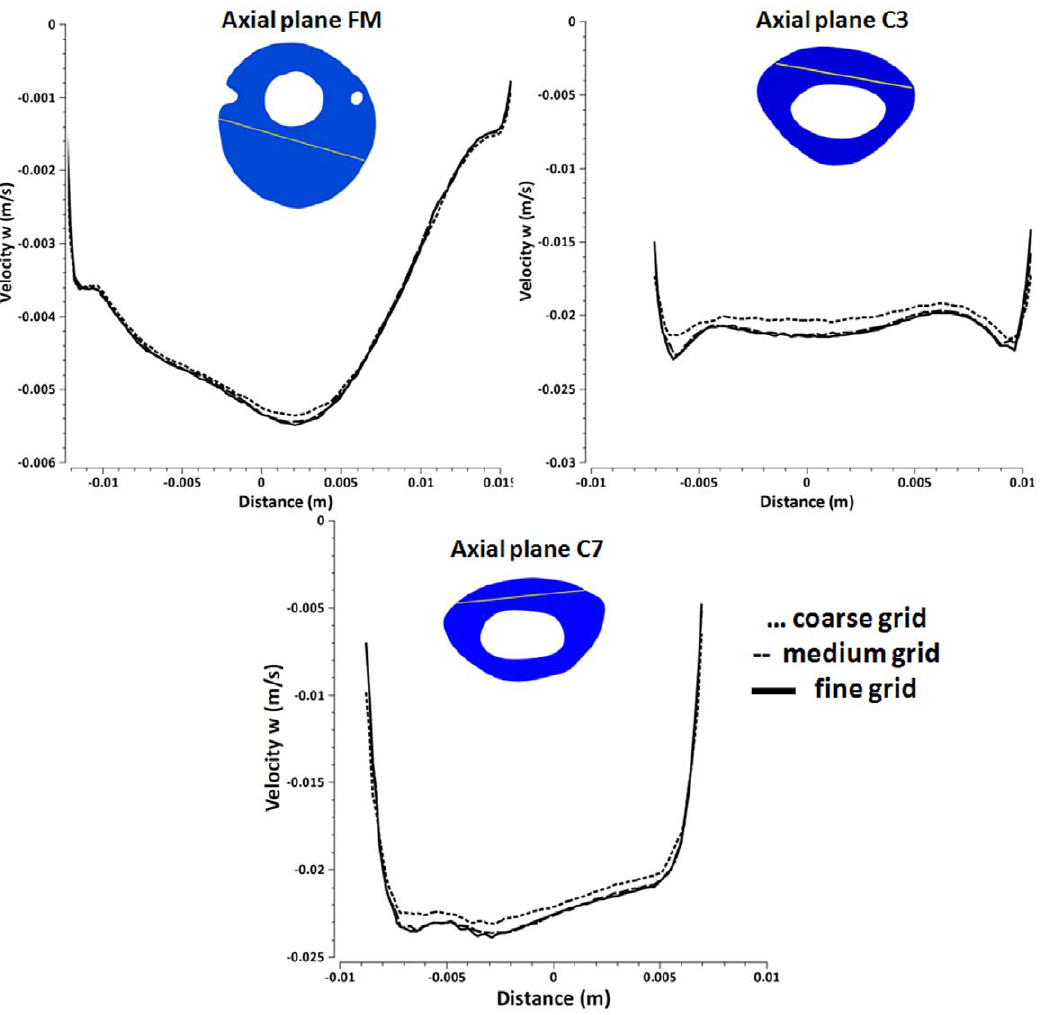
Figure 8. Velocity-w at axial locations through the spinal cord for three grids of different density. Plots of peak systolic velocity in the z direction (velocity w) along vectors through the cervical spinal cord for three different axial locations as calculated with three grids (a) Velocity-w along the vector at the cross-section of axial plane FM, (b) Velocity-w along the vector at the cross-section of axial plane C3 (c) Velocity-w along the vector at the cross-section of axial plane